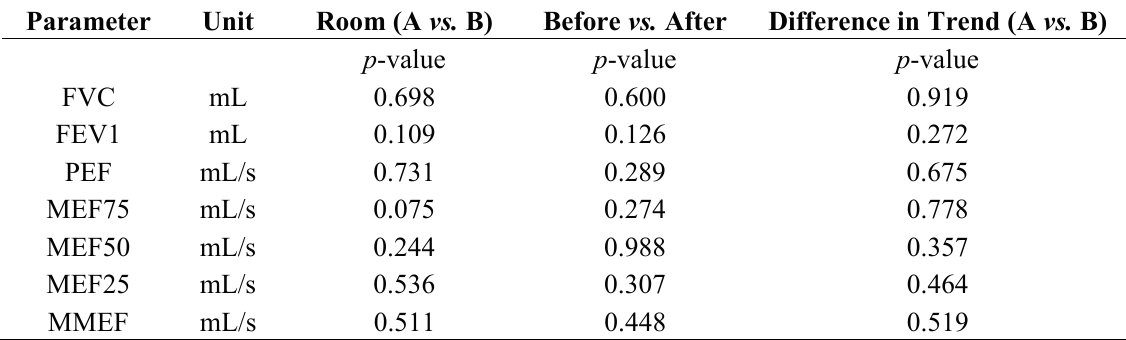
Table 3. Results of ANOVA of spirometric